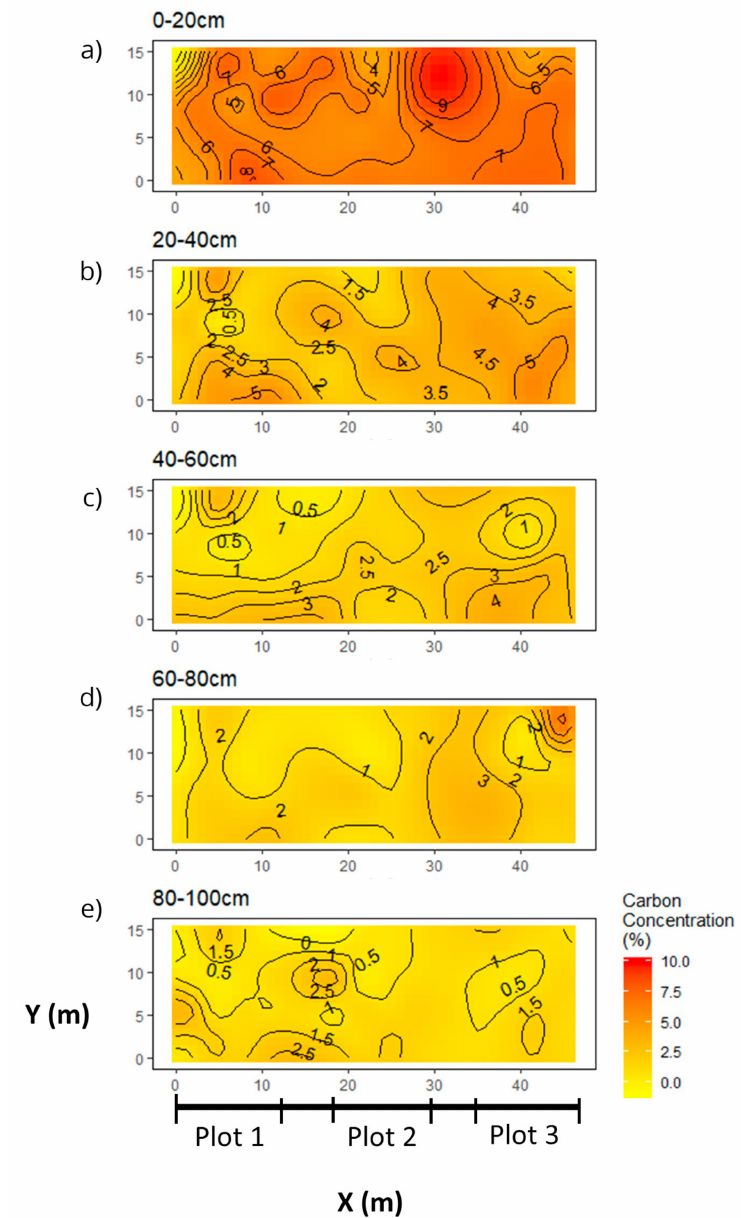
Figure 3. Interpolated contour maps of C concentration (% C) at each sampling depth demonstrat- ing the lateral and vertical heterogeneity throughout the soil profile. ( a ) 0–20 cm; ( b ) 20–40 cm; ( c ) 40–60 cm; ( d ) 60–80 cm; ( e ) 80–100 cm. The y-axis is parallel to the slope of the ridge. The aspect of the slope 117 ◦ for plot 1 and 130 ◦ for plots 2 and